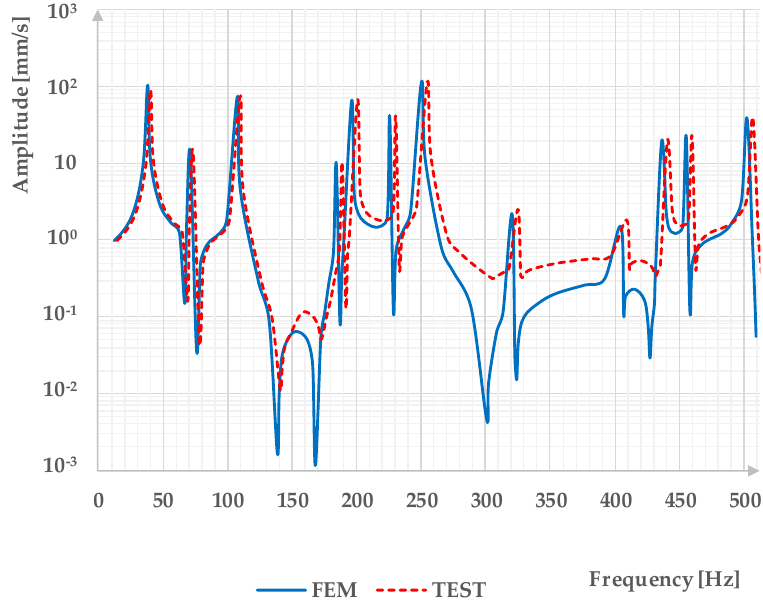
Figure 6. Frequency response function: experimental-numerical comparison.